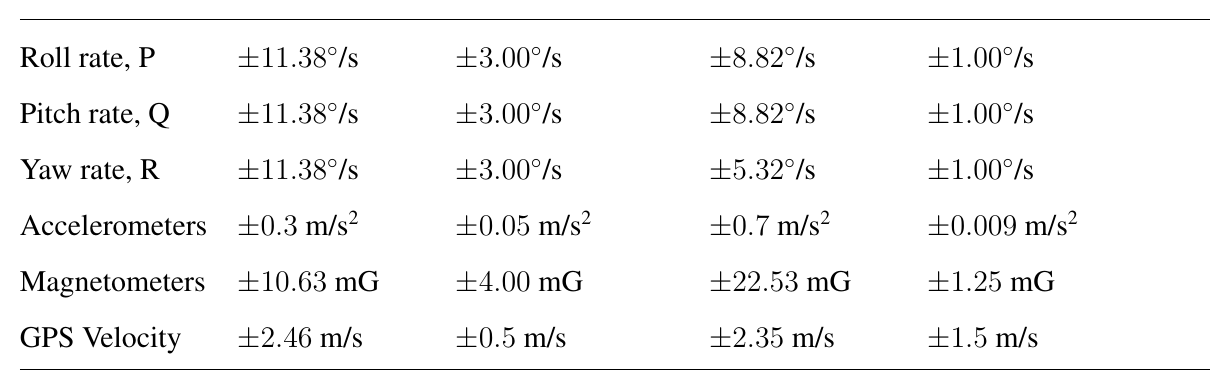
UKF tolerances and actual onboard sensors: Maximum bias and random error standard